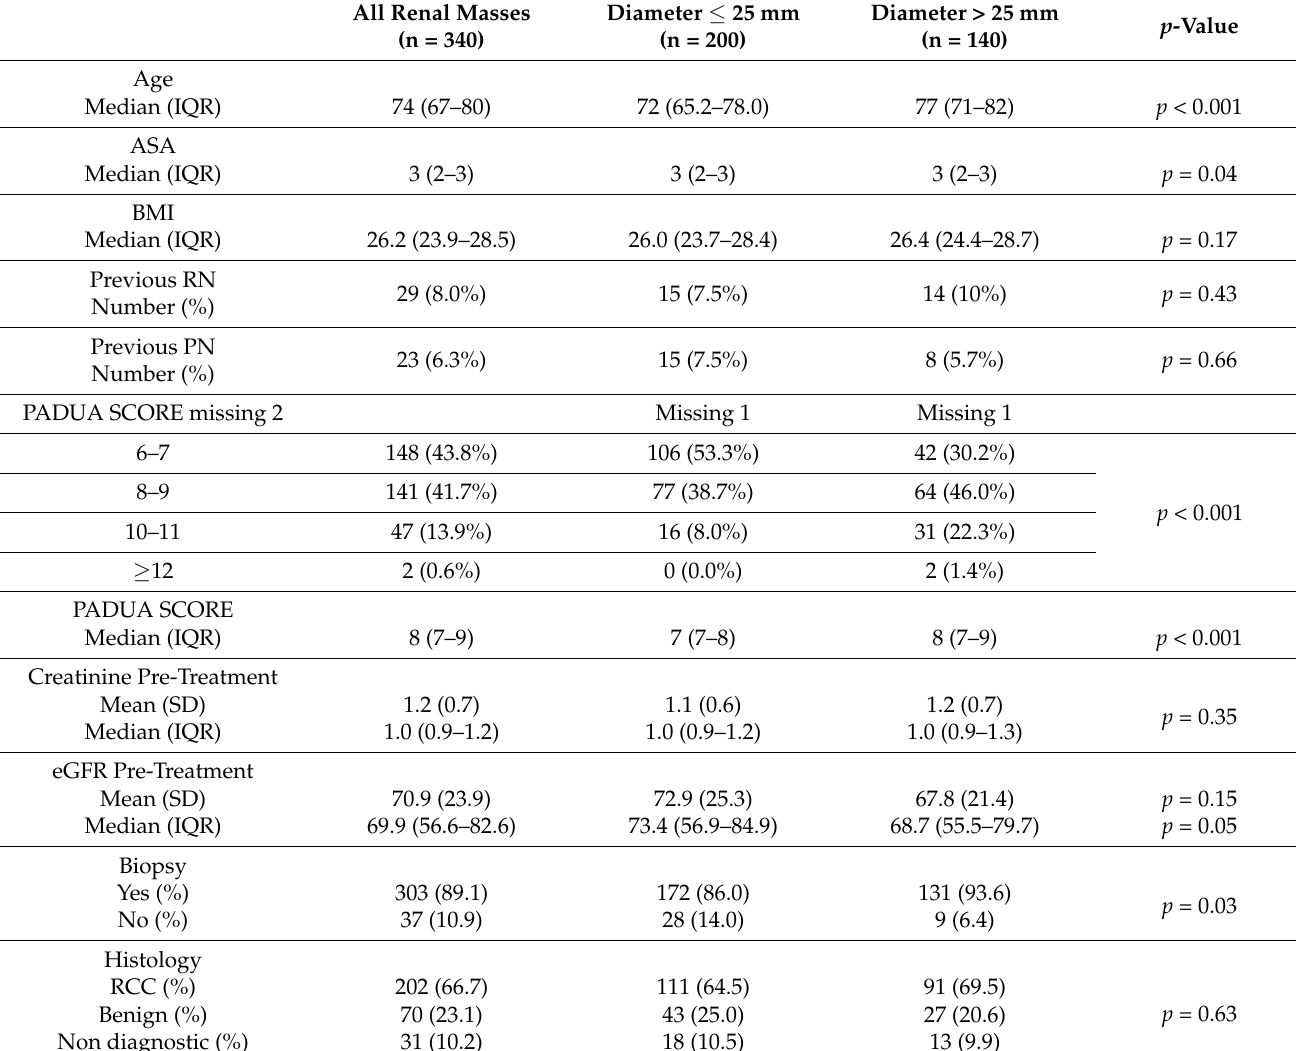
Table 1. Main characteristics of the population, stratified according to the diameter cut-off. All Renal